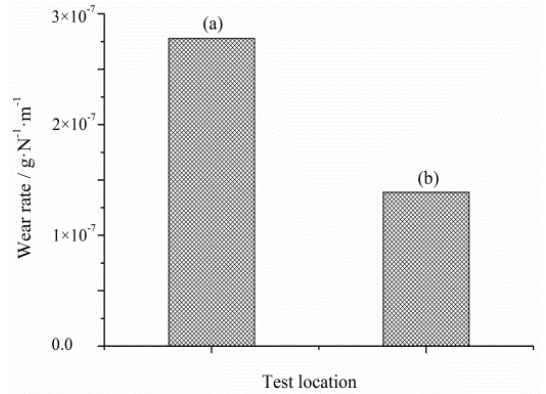
Figure 8. The wear rates of (a) the top of the gradient remelted layer (M1), and (b) the position where the hardness was two-thirds of the top of the remelting layer (M2).